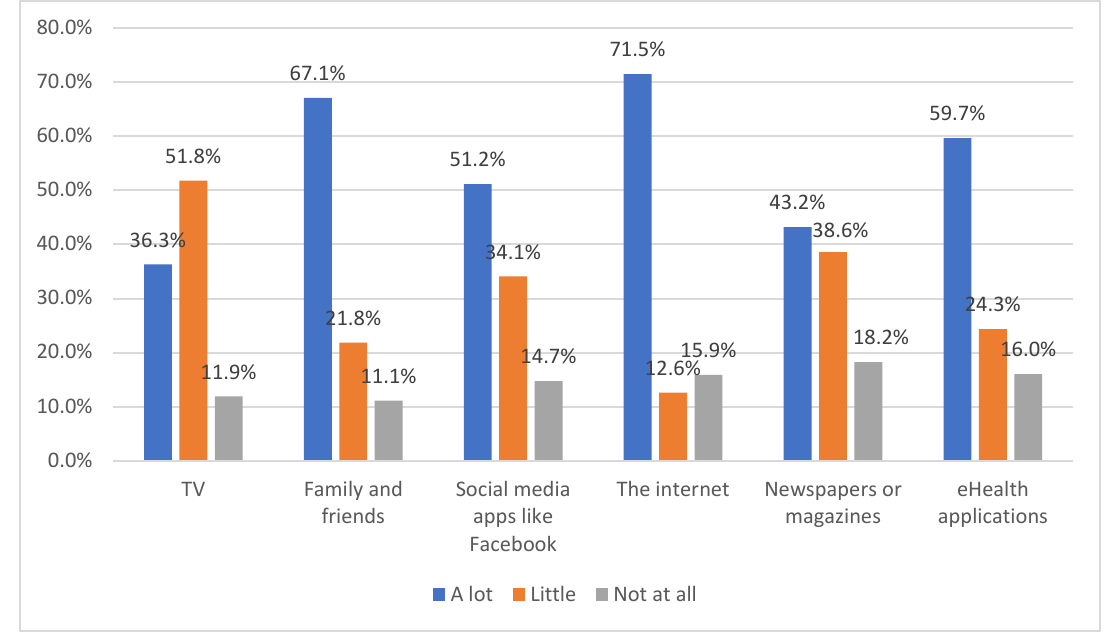
Figure 1. Sources of health information. Table 2. Online behavior of the